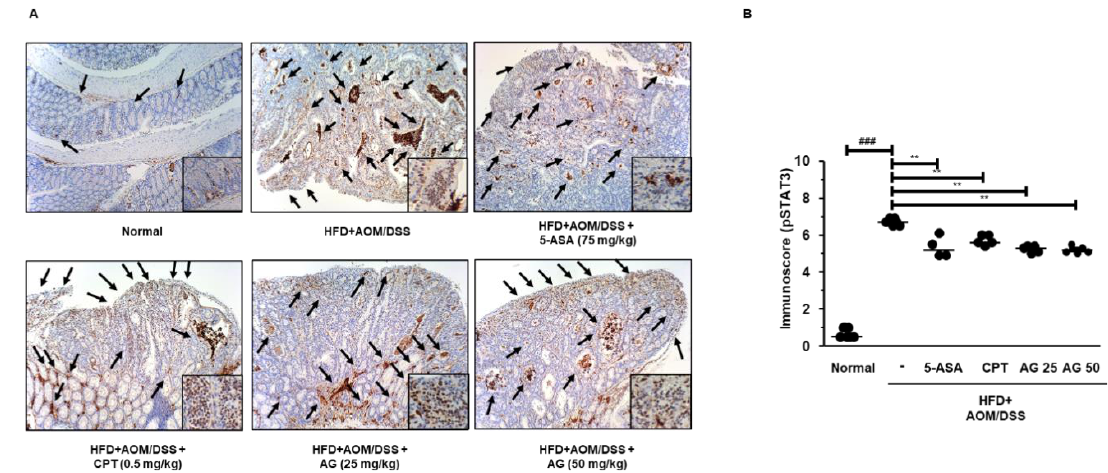
Figure 6. E ff ects of AG on the activation of STAT3 in the HFD-propelled CAC mice model. ( A ) The manifestation and translocation to the nucleus of pSTAT3 (Tyr705) in the colon tissues were performed by immunohistochemistry. ( B ) pSTAT3 (Tyr705) immune score in each group was estimated. The values are the mean ± SD ( n = 10); ### p < 0.001 vs. normal group; ** p < 0.01, *** p < 0.001 vs. the HFD + AOM / DSS group; significant di ff erences between the treated groups were determined by ANOVA and Dunnett’s post-hoc test.